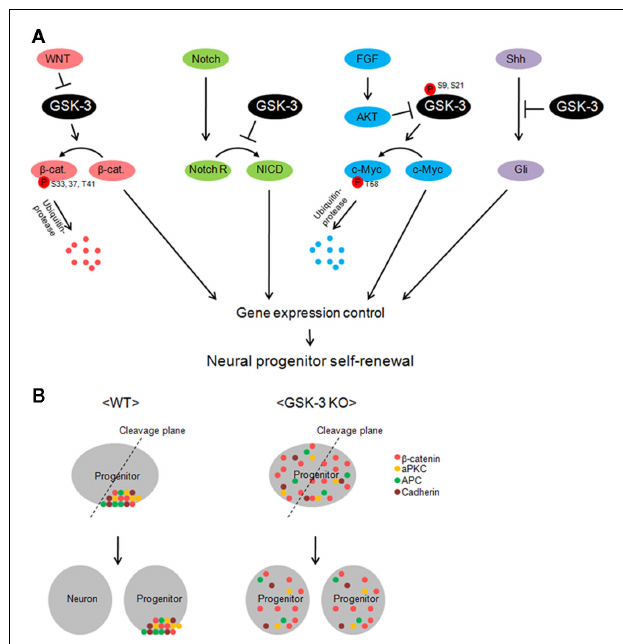
FIGURE 2 | Glycogen synthase kinase-3 is a key regulator of multiple signaling pathways in neural progenitors. (A) GSK-3 controls gene induction by regulating the levels of transcription factors in neural progenitors. β -catenin is degraded via GSK-3 phosphorylation-dependent ubiquitin-protease machinery in the resting state. However, inhibition of GSK-3 byWnt allows β -catenin accumulation. GSK-3 is also critical in the control of c-Myc levels. c-Myc is phosphorylated atT58 and recruited by ubiquitin-protease for degradation. FGF inhibits GSK-3 via AKT-mediated phosphorylation at S9 (beta) or S21 (alpha) and leads to increase in c-Myc levels. Inhibition of GSK-3 increases Notch intracellular domain (NICD) and Gli proteins in neural progenitors.Thus, GSK-3 activity is critical in the control of transcription factors in multiple signal pathways, which eventually regulates neural progenitors during development. (B) A schematic model of the GSK-3 function in apical–basal polarity and neurogenesis. GSK-3 is required for polarity establishment and possibly for neurogenic division of progenitors. Polarity-associated molecules including β -catenin, atypical PKC, APC, and cadherin are localized in the apical membrane.When progenitors divide, daughter cells that inherit the polarity molecules are thought to become progenitors.Without the polarity protein, cells become neurons. However, in GSK-3-deleted neural progenitors, polarity molecules are distributed throughout the cell.Thus, wherever the cleavage plane is positioned, daughter cells have almost same composition of the molecules. This may be an important factor that leads constant self-renewal of progenitors in GSK-3-deleted